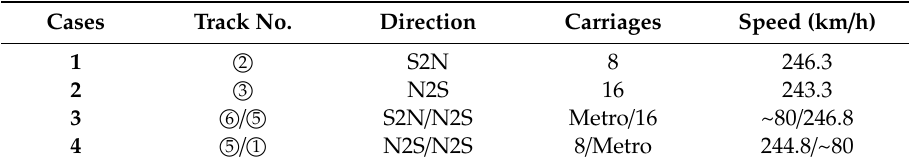
Figure 14. ( a ) Range profile of view S2b. Vertical gray lines indicate the radar bins 21, 23, 26, 27 and 28; ( b ) scheme of the radar geometry using the lidar point clouds. Table 4. Loading cases of view